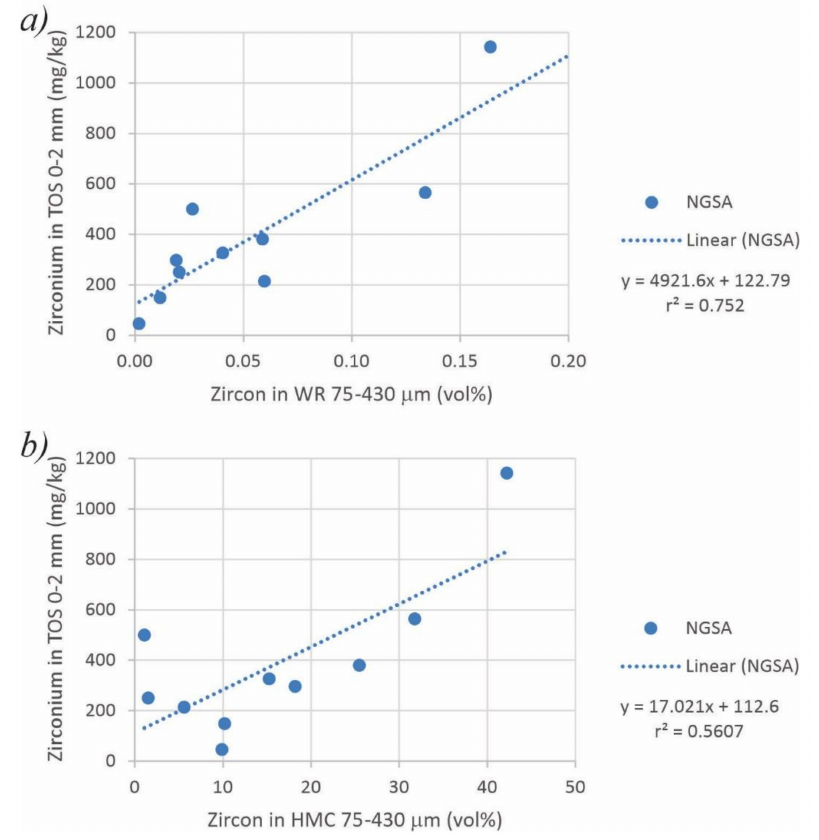
Figure 4. Scatterplots and least-square regressions of Zr in the 10 NGSA TOS coarse (<2 mm) fractions vs. zircon concentration in the whole rock (WR) ( a ) and heavy mineral concentrates (HMC) ( b )